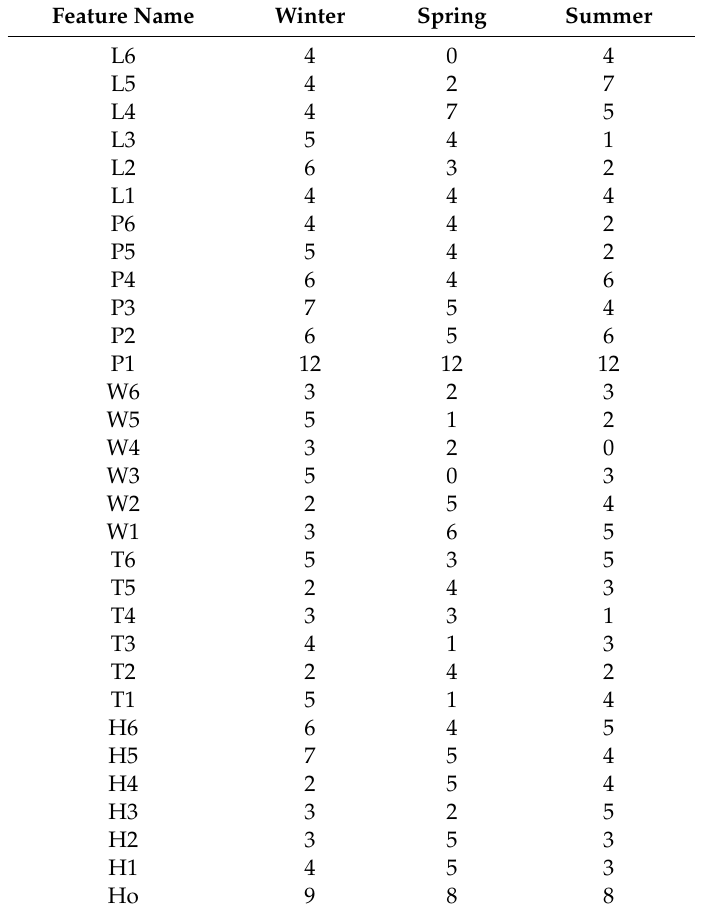
Table 3. Number of times a feature is selected season-wise.